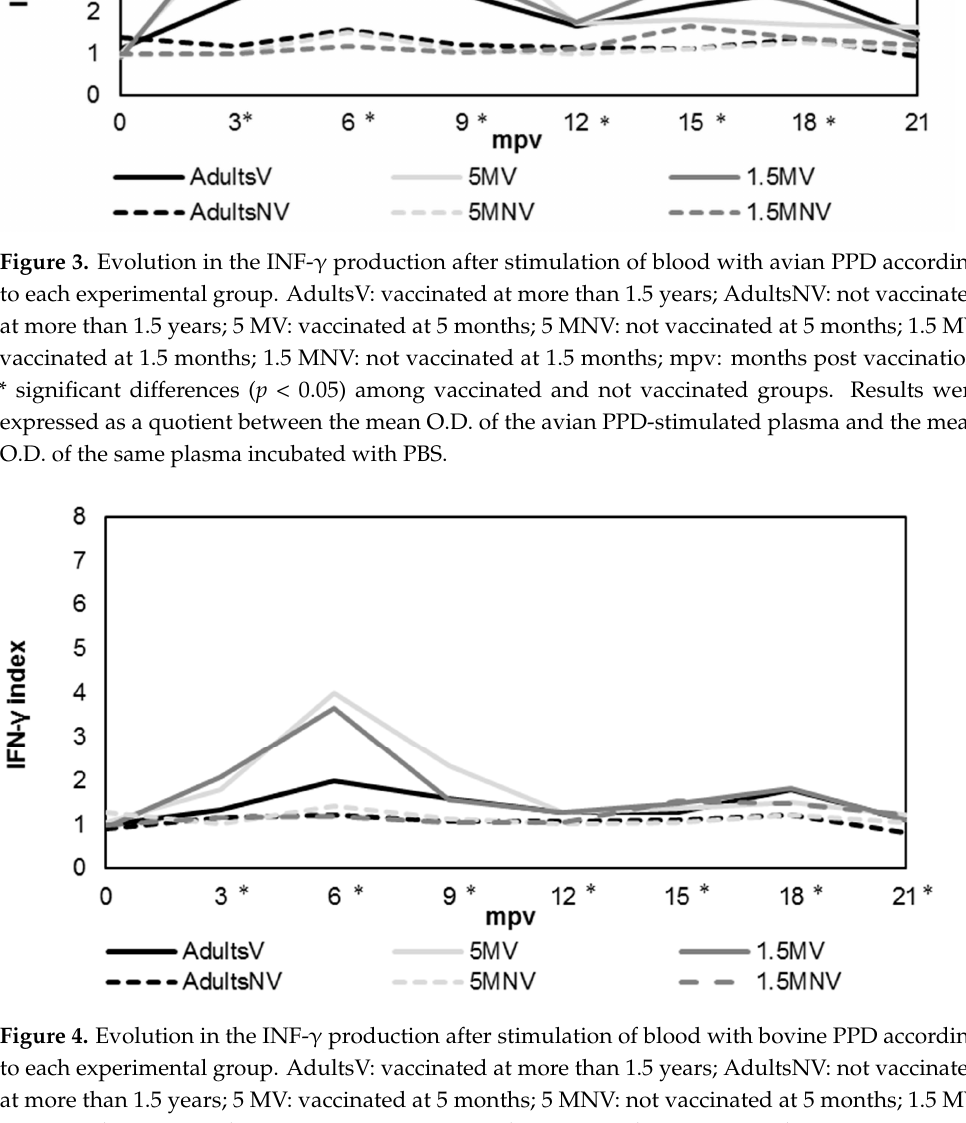
Figure 3. Evolution in the INF ‐γ production after stimulation of blood with avian PPD according to each experimental group. AdultsV: vaccinated at more than 1.5 years; AdultsNV: not vaccinated at more than 1.5 years; 5 MV: vaccinated at 5 months; 5 MNV: not vaccinated at 5 months; 1.5 MV: vaccinated at 1.5 months; 1.5 MNV: not vaccinated at 1.5 months; mpv: months post vaccination; * significant differences ( p < 0.05) among vaccinated and not vaccinated groups. Results were ex ‐ pressed as a quotient between the mean O.D. of the avian PPD ‐ stimulated plasma and the mean O.D. of the same plasma incubated with PBS.